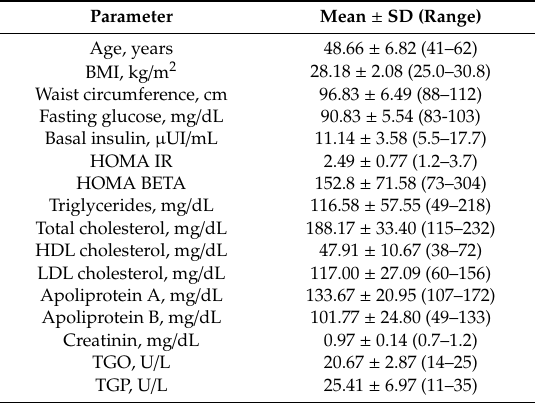
Table 1. Volunteers’ baseline characteristics ( n =